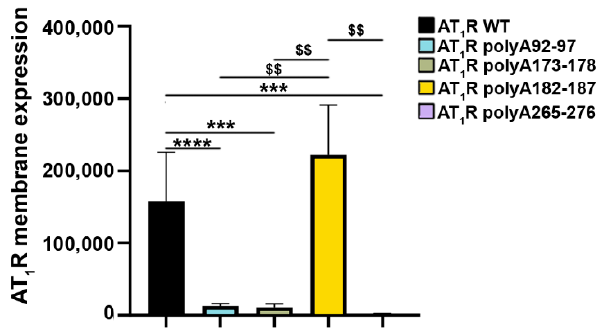
Figure 4. Angiotensin II type 1 receptor (AT 1 R) extracellular loop (EL)-variant cell-surface expres- sion in mammalian cells. Human embryonic kidney 293T cells (HEK293Ts) were transfected with sequences coding for either HiBiT-tagged wild type (WT) receptors or HiBiT-tagged mutant receptors (amino acids 92 to 97, EL1 (AT 1 R polyA92-97); amino acids 173 to 178 and amino acids 182 to 187, EL2 (AT 1 R polyA173-178 and AT 1 R polyA182-187, respectively); and amino acids 265 to 276, EL3 (AT 1 R polyA265-276) to determine the cell-surface expression of the variants. SEMs derived from five to twelve experiments are shown together with p -values for Mann–Whitney tests (*** p < 0.001, **** p < 0.0001 as compared with AT 1 R WT without stimulation; $$ p < 0.01 as compared with AT 1 R polyA 182-187A).